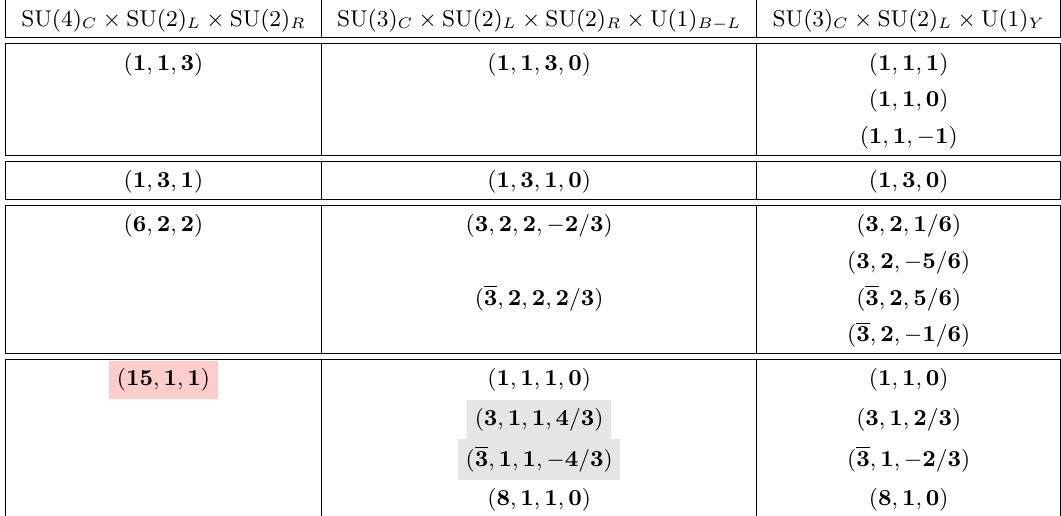
Table 8 . Decomposition of 45 -Higgs, which is a real field. Multiplets highlighted in red, blue, and green contribute to the RGE running of the gauge coupling in the energy scale in between SO(10) and G 422 , G 422 and G 3221 , and G 3221 and G 321 , respectively. Multiplets highlighted in gray represent the Goldstone